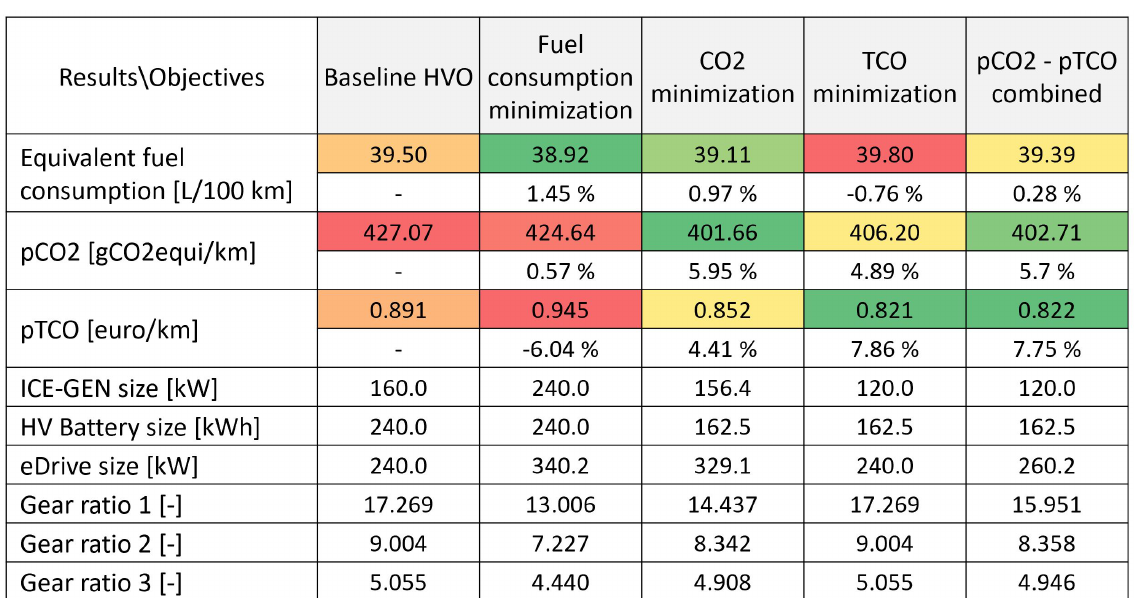
Figure 9. Quantitative comparison of HVO − fueled powertrain size solutions running on VECTO interurban cycle focused on minimisation of fuel consumption, carbon footprint ( pCO 2 ), lifetime costs ( pTCO ) and environmental-economic balanced objective ( pCO 2 − pTCO ) against the baseline case. The corresponding choice of optimised powertrain dimensions have also been